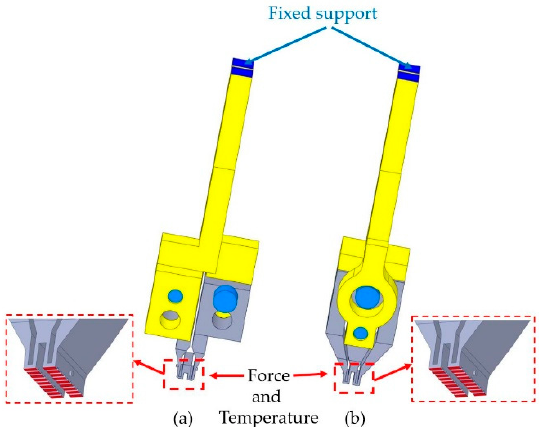
Figure 11. The boundary conditions for structural simulation of ( a ) series and ( b ) parallel WTs.